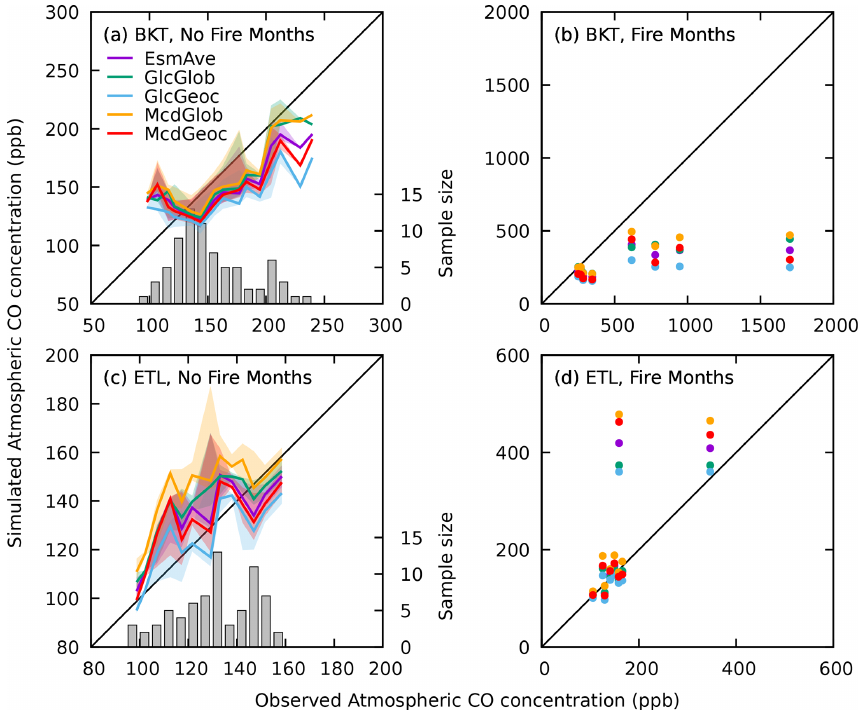
Figure 5. Comparisons of observed and simulated monthly atmospheric CO concentration (ppb) over the period 2009–2015. The conditional quantile plots for no-fire months at (a) BKT and (c) ETL. The scatter plots for fire months at BKT (b) and (d)